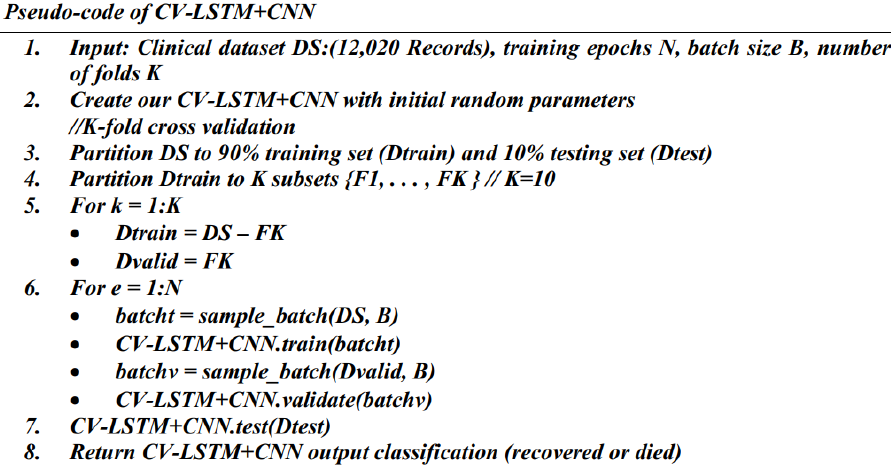
Figure 8. The pseudo-code of the CV-LSTM+CNN